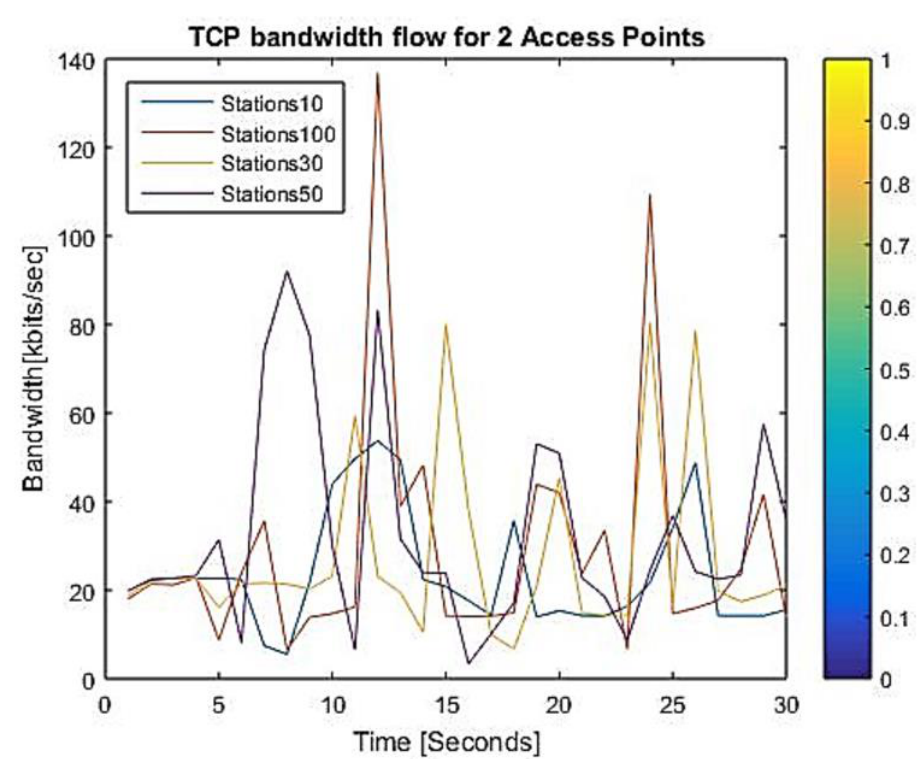
Figure 7. TCP bandwidth for 2 access points.